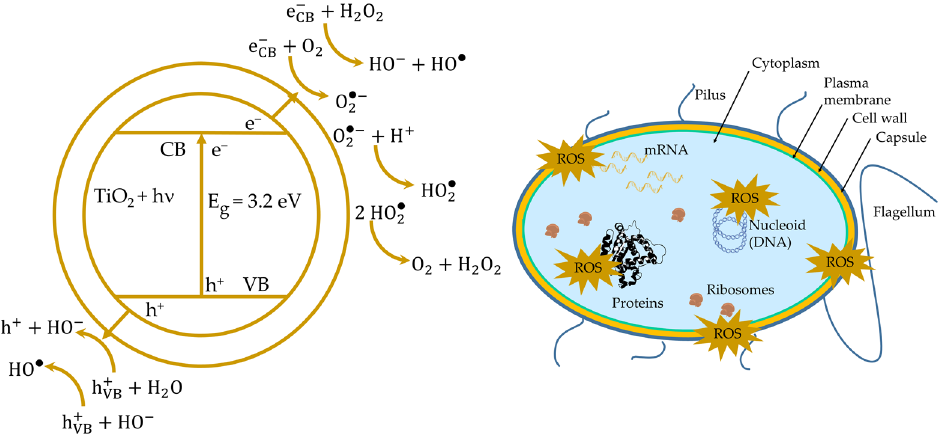
Figure 1. Schematic representation of ROS generation and disinfection via heterogeneous photoca-